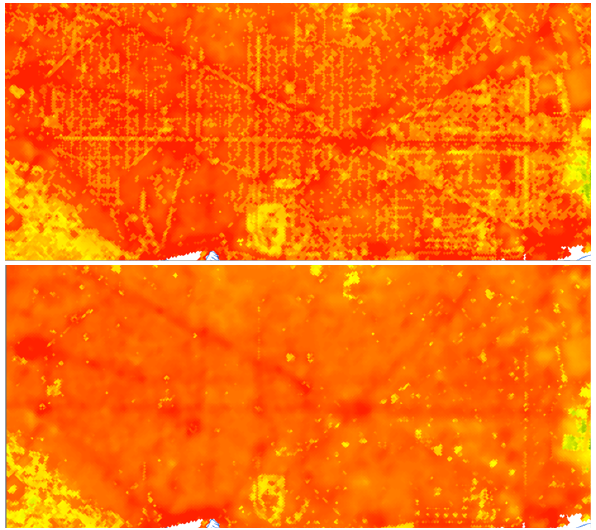
Figure 12. Standard vs. new method to obtain nighttime